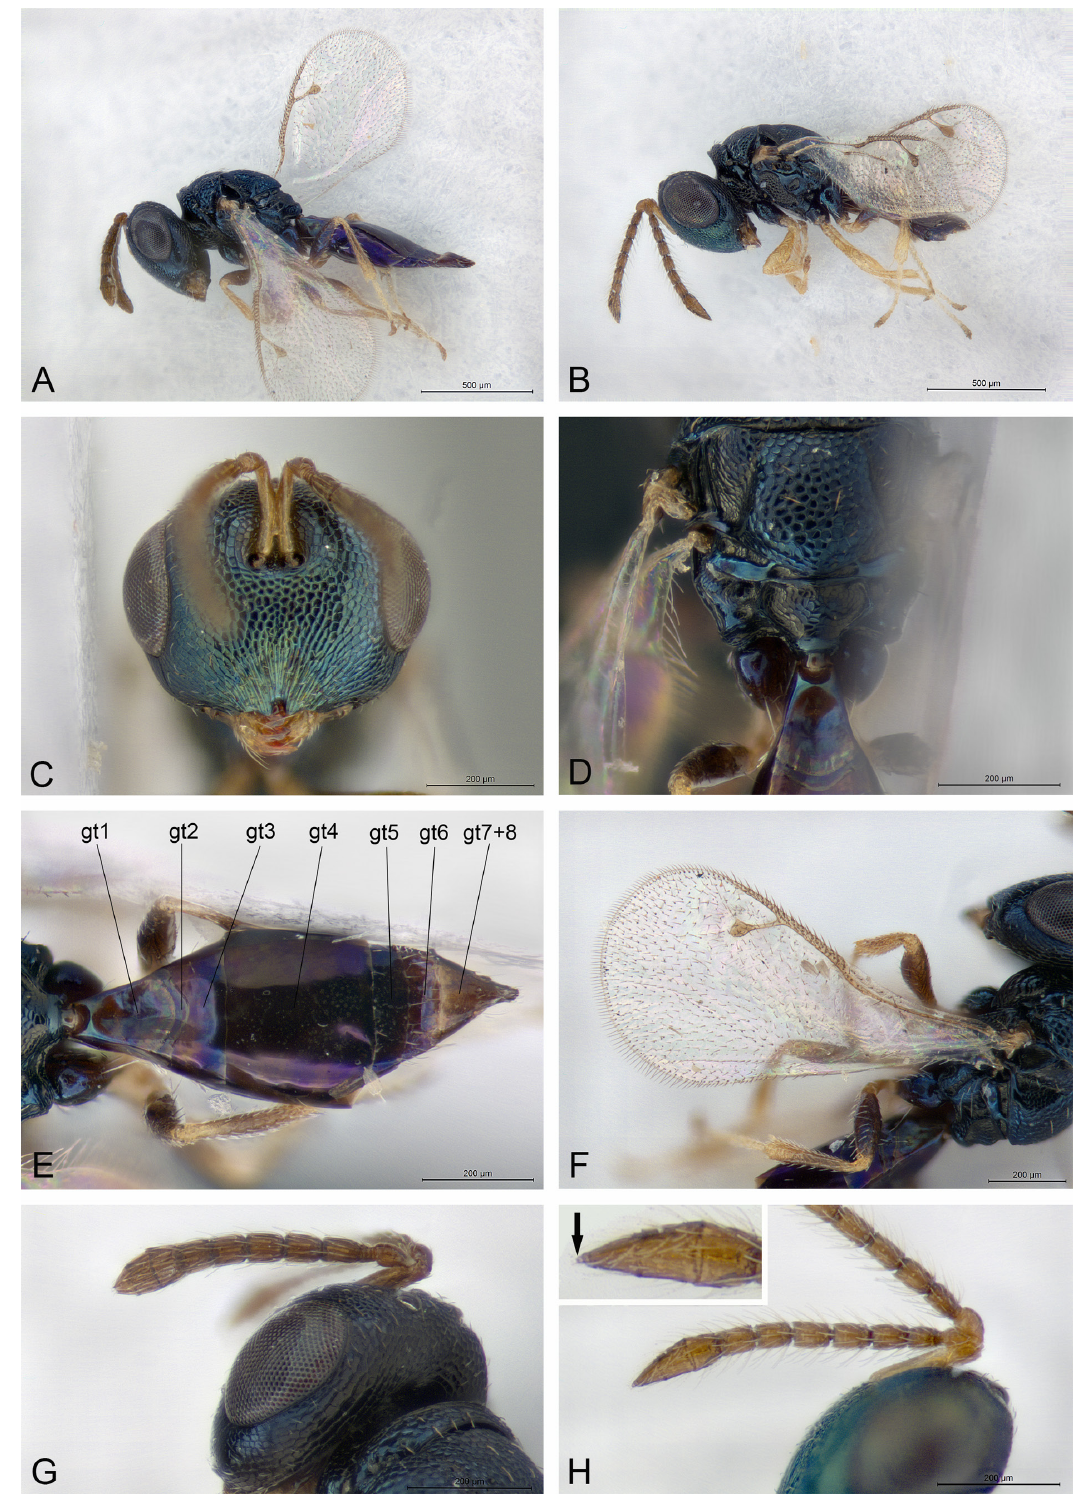
Fig. 1. Habritella africana sp. nov. A, C–G . Holotype, ♀ (NHMUK). B, H . Allotype, ♂ (NHMUK). A . Habitus in lateral view. B . Habitus in lateral view. C . Head in frontal view. D . Detail of mesosoma in dorsal view. E . Metasoma in dorsal view. F . Fore wing in dorsal view. G . Antenna in lateral view. H . Antenna in lateral view (inset: detail of clava indicating the terminal